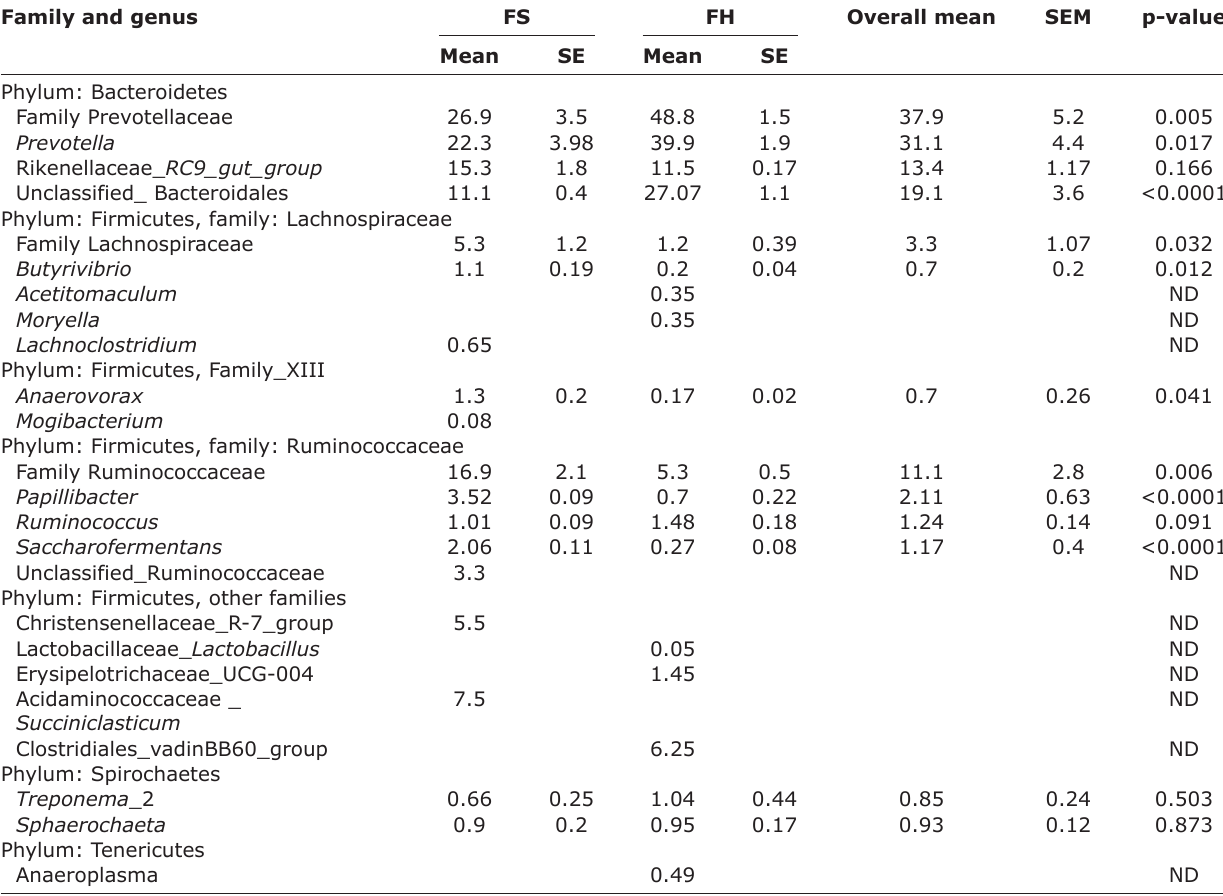
Table-6: The relative abundances (%) of bacterial families and genera in the rumen of camels fed different forages. Family and genus